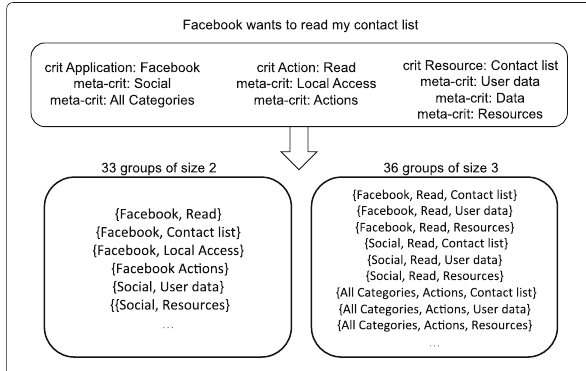
Fig. 5 Decomposition of a request in criteria, meta-criteria, and groups of criteria